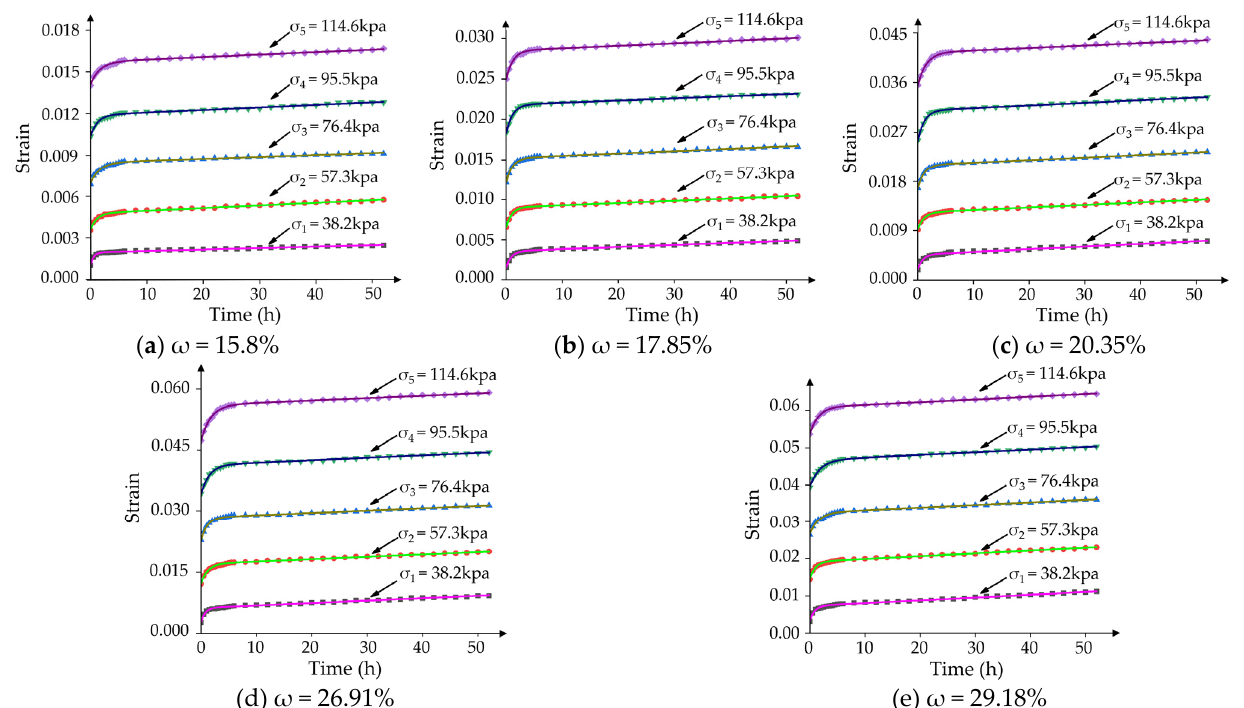
Figure 8. Fitting results of strain–time curves: ( a ) ω = 15.8%, ( b ) ω = 17.85%, ( c ) ω = 20.35%, ( d ) ω = 26.91% and ( e ) ω = 29.18% . Table 3. Creep model parameters .